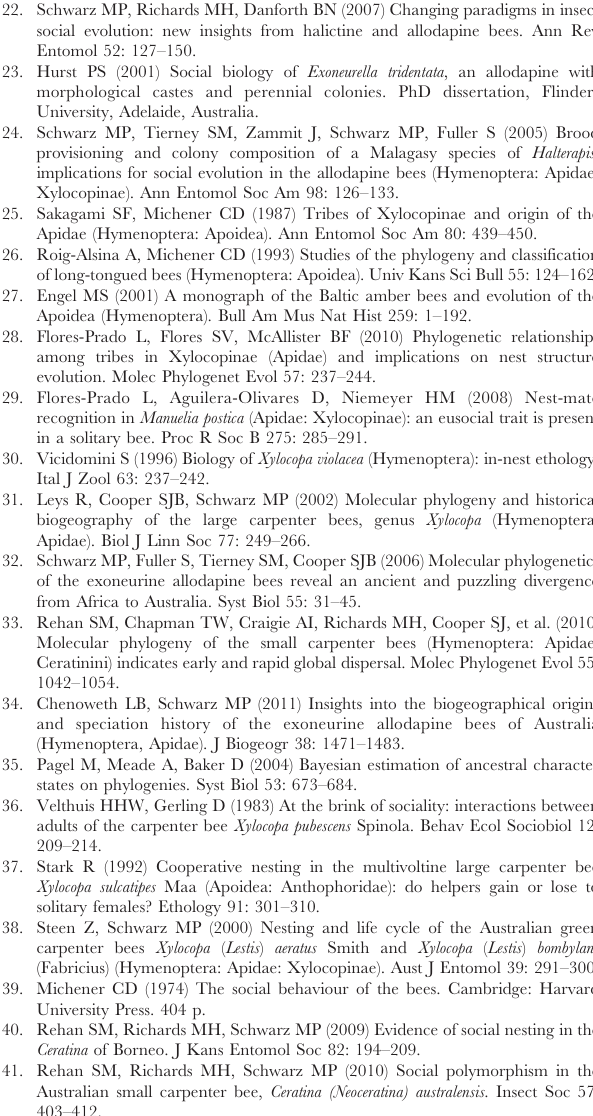
Figure S3 Bootstrap consensus tree from a maximum parsimony analysis implemented in PAUP*.